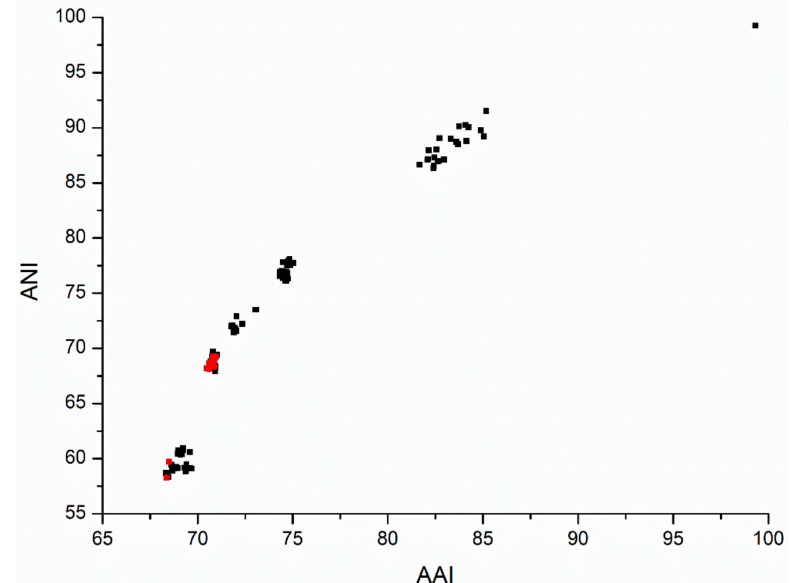
Figure 2. Relationships between average nucleotide (ANI) and amino acid identity (AAI), black dots for all pairs of the genomes and red dots for D. tibetensis Y620-1 and the reference